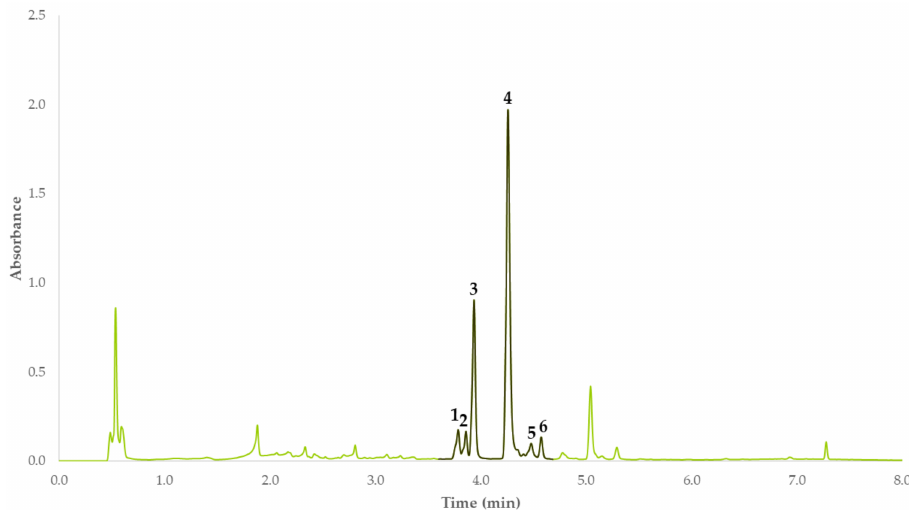
Figure 1. Chromatogram of a M. oleifera extract at λ = 350 nm. Q3GLU ( 1 ): quercetin 3- O -glucoside; QMGLU; ( 2 ): quercetin malonyl glucoside; QHMGGLU ( 3 ): quercetin hydroxy methyl glutaroyl glucoside; QAGLU ( 4 ): quercetin acetyl glucoside; K3GLU ( 5 ): kaempferol-3-glucoside; I3GLU ( 6 ):